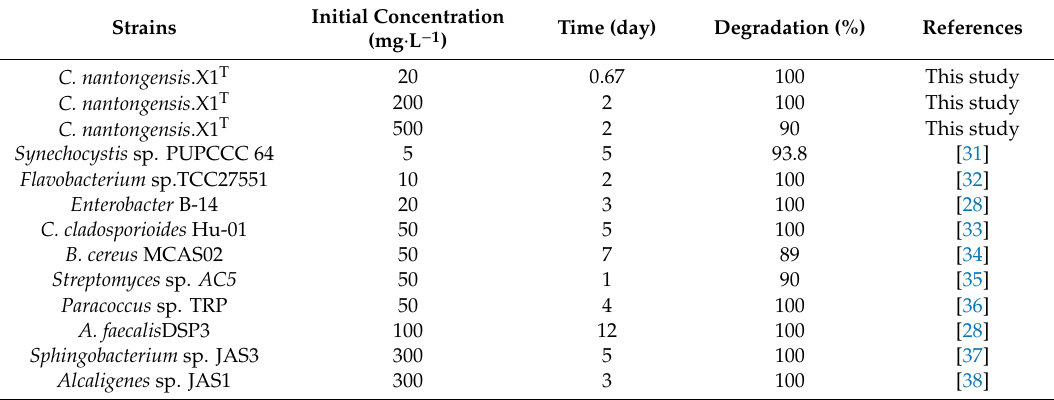
Table 3. Degradation rates of strain X1 T and other chlorpyrifos-degrading microorganisms.